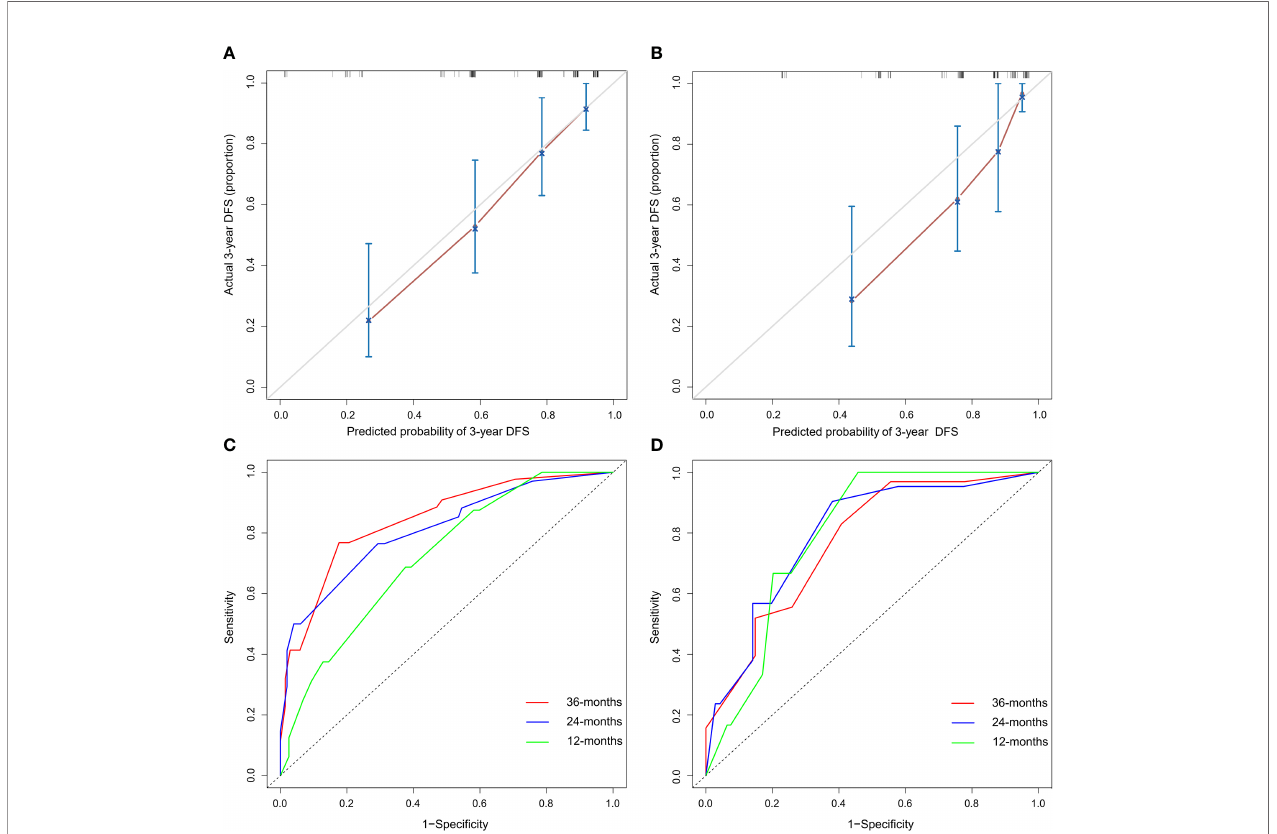
FIGURE 2 | Evaluation of the prognostic nomogram. (A – D) Calibration curves for the nomogram in the training cohort (A) and validation cohort (B) . The x-axis shows the predicted probability of a DFS event. The y-axis shows the actual DFS outcome. (C, D) Receiver operating characteristic (ROC) curve for the nomogram in the training cohort (C) and validation cohort (D) ; the AUCs for 1-, 2- and 3-year DFS prediction were 0.720 (95% CI: 0.601 – 0.839), 0.810 (95% CI: 0.723 – 0.897) and 0.843 (95% CI: 0.770 – 0.916) in the training cohort and 0.793 (95% CI: 0.681 – 0.906), 0.795 (95% CI: 0.693 – 0.897) and 0. 771 (95% CI: 0.648 – 0.893) in the validation cohort, respectively.